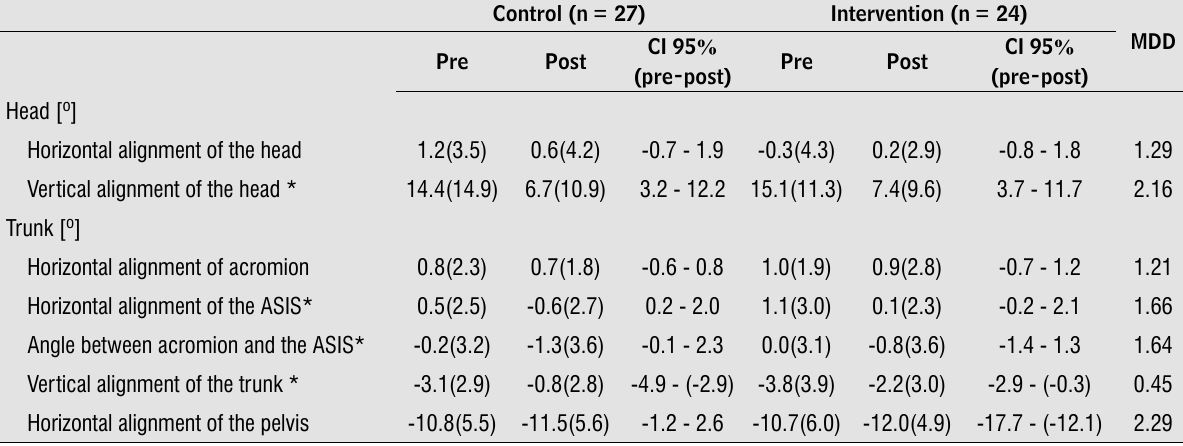
Table 4 – Quantitative postural assessment obtained by PAS/SAPo. Data are presented as mean and standard deviation [ mean(SD) ]